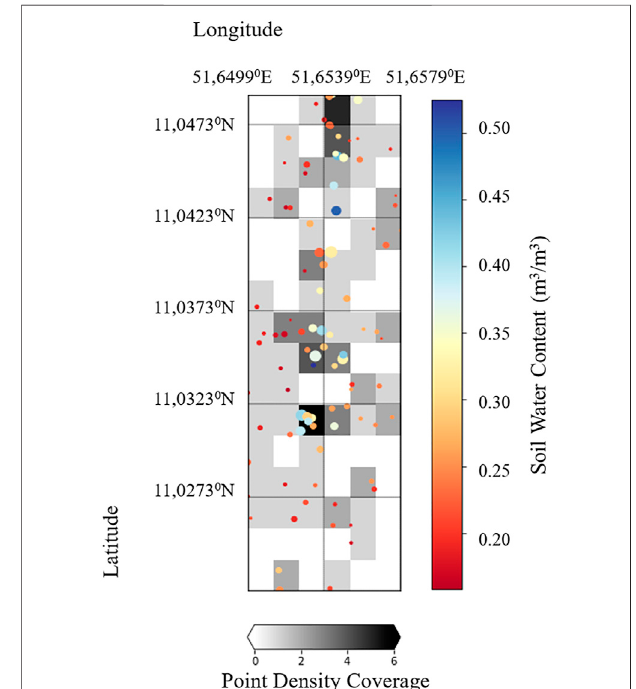
FIGURE8| Pointdensitycoverage(grayscale)andthederivedsoilwater content intensity after Topp formula. The fi gure shows several grid cells where no measurement points are located and therefore, these map values represent only interpolated values. There are also grid areas where maximum values were measured and where surrounding grid areas have no measuredvaluesasabasis.Insuchcases,thein fl uenceofmaximumvaluesis particularly